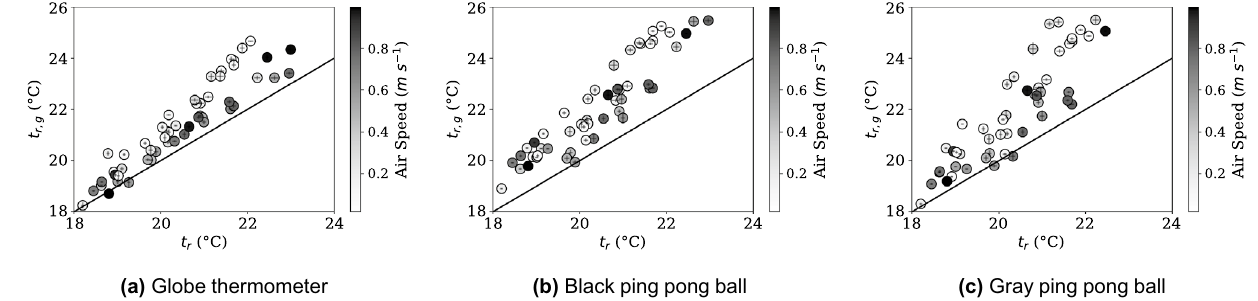
Figure 5. Mean radiant temperature, t r , g measurements using the ISO7726 correction factor for globe thermometers do not match the mean radiant temperature measurement produced using a 6 pyrgeometer x representing a perfect correlation. Shading indicates air speed present for each sensor, t r . The black line is y = data point, and error bars for the standard deviation of 30 minutes of data averages are included.